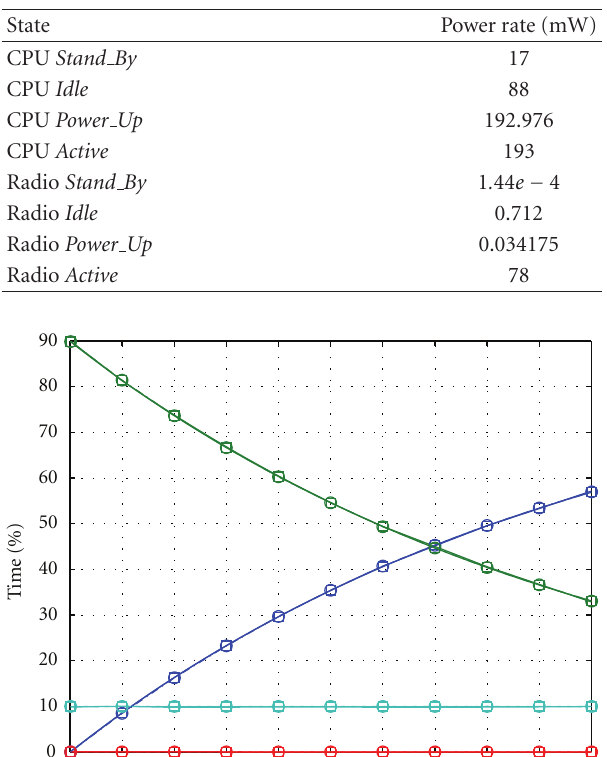
Table 2: Simulation parameters. Table 3: System model Petri net power parameters.